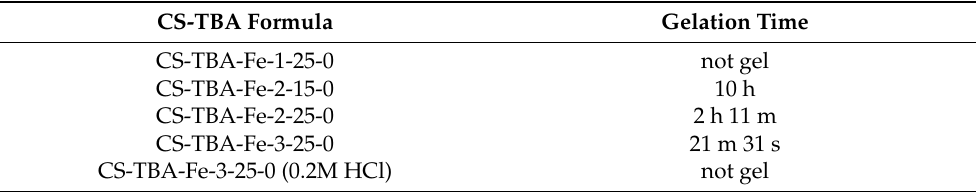
Table 1. Gelation time of CS-TBA hydrogels with different